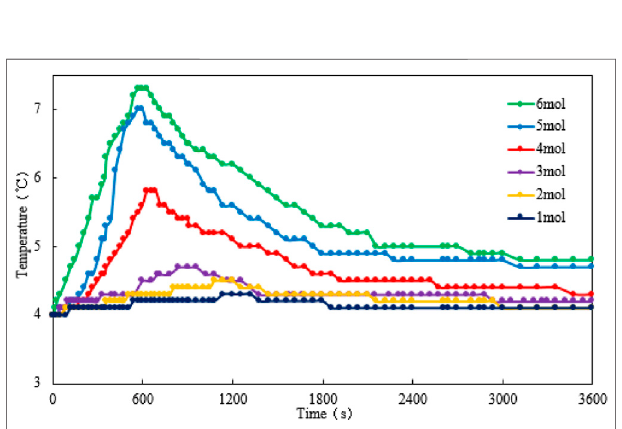
FIGURE 9 | Gas production rate vs. time at different reactant concentrations.